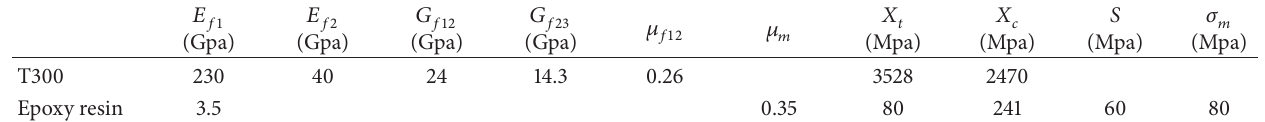
Table 2: Mechanical properties of the constituent materials.